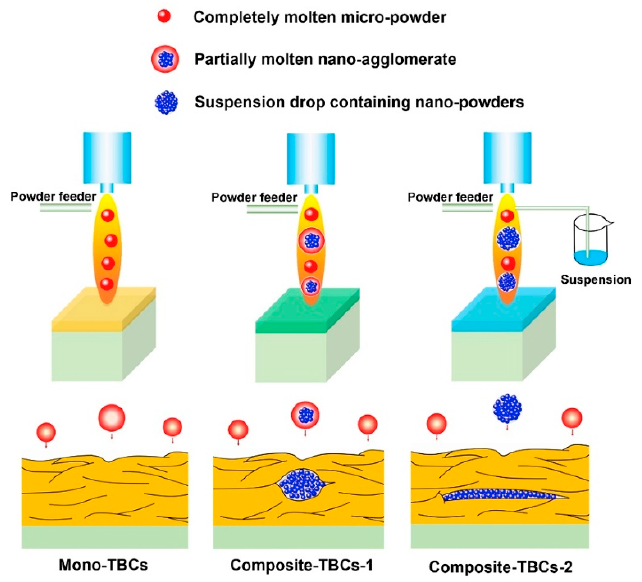
Figure 46. Schematic diagram of the three kinds of TBCs: (i) mono-layered TBCs without nano-inclusions (mono-TBCs); (ii) composited TBCs with isotropic nano-inclusions (composite-TBCs-1); (iii) composited TBCs with anisotropic nano-inclusions (composite-TBCs-2) [234] .